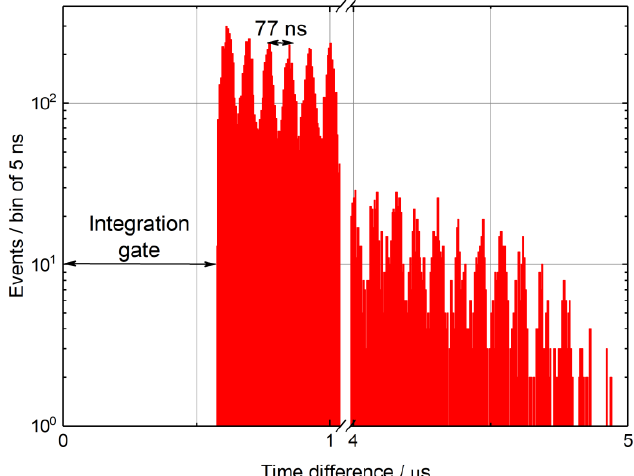
Fig. 4. Enlarged first peak from Fig. 3(b) which corresponds to the time difference histogram for events from the same macropulse. No events have the time difference less that the integration gate length that was of 577 ns for this experiment. The small peaks are spaced by approximately 77 ns, and this corresponds to the period of micropulses.